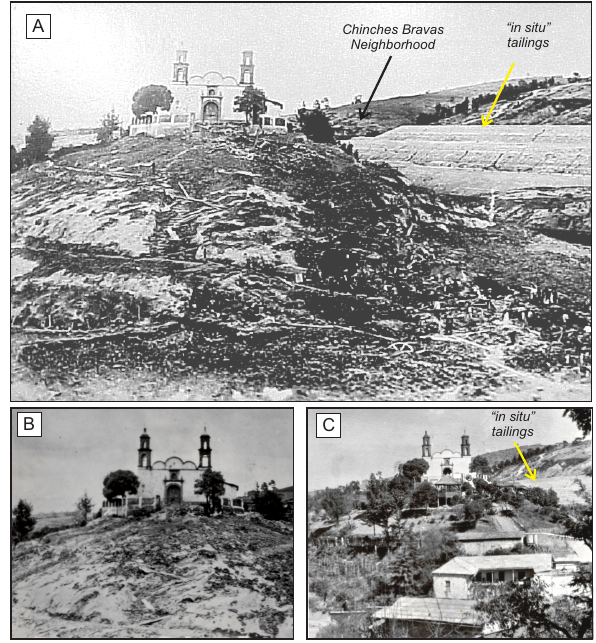
Figure 6. (a) Panoramic and (b) close-up view from the south- west of San Jesus del Monte hill and church after the 27 May 1937 flood with rubble, and wood planks dispersed on the surface and the striped slopes of the hill. (c) View of the same hill prior to the flood that shows houses on its southern